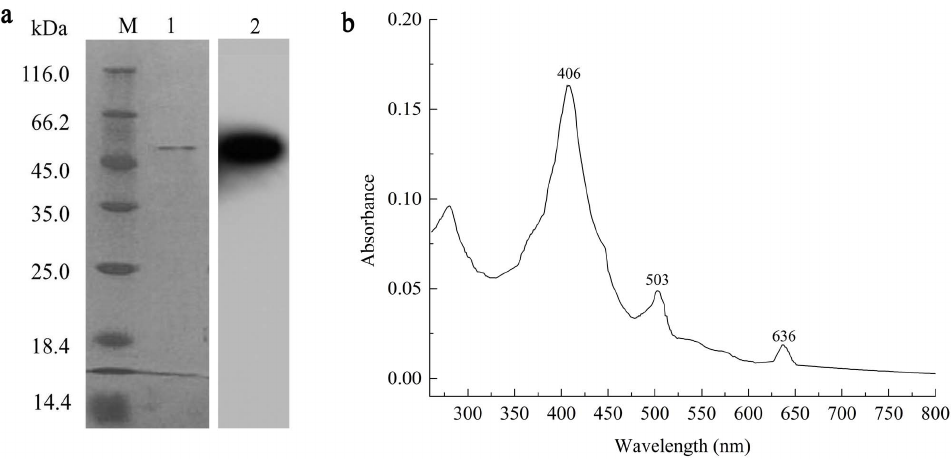
Figure 4. SDS–PAGE and western blotting analysis and spectral characteristics of purified Svi DyP. a . SDS–PAGE and western blotting analysis. Lanes: M, molecular mass standard; (1) SDS–PAGE analysis of purified Svi DyP. (2) western blot analysis of the purified Svi DyP recognized by an anti-His6 tag mouse monoclonal antibody. b . Spectral characteristics of purified Svi DyP, as determined by hemoprotein assay. Purified Svi DyP (1 mg ml 2 1 ) in 25 mM phosphate buffer (pH 7.0) was scanned at 300–800 nm to identify the Soret band.